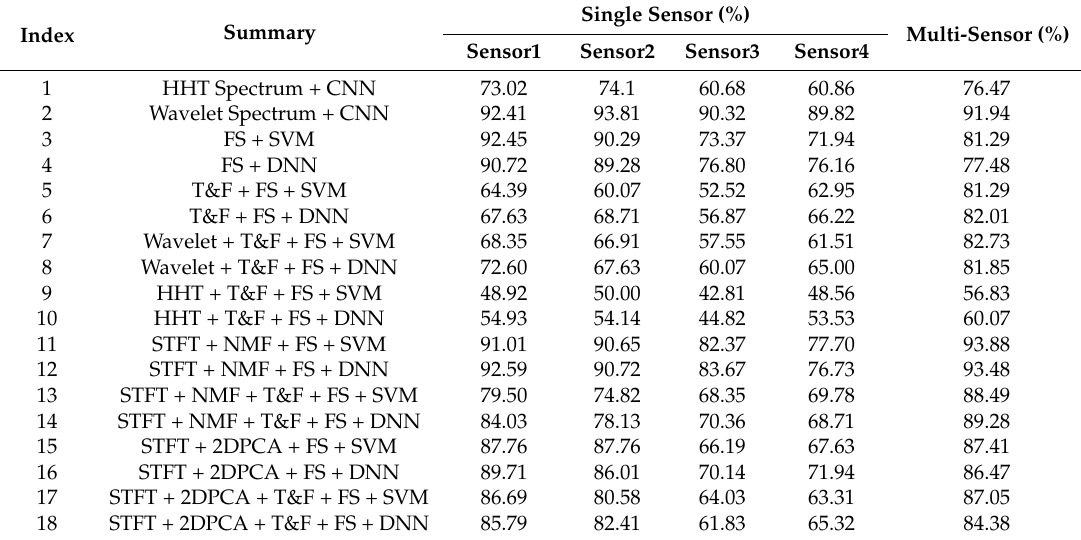
Table 7. Diagnostic accuracies of the baseline methods for classifying the defect types